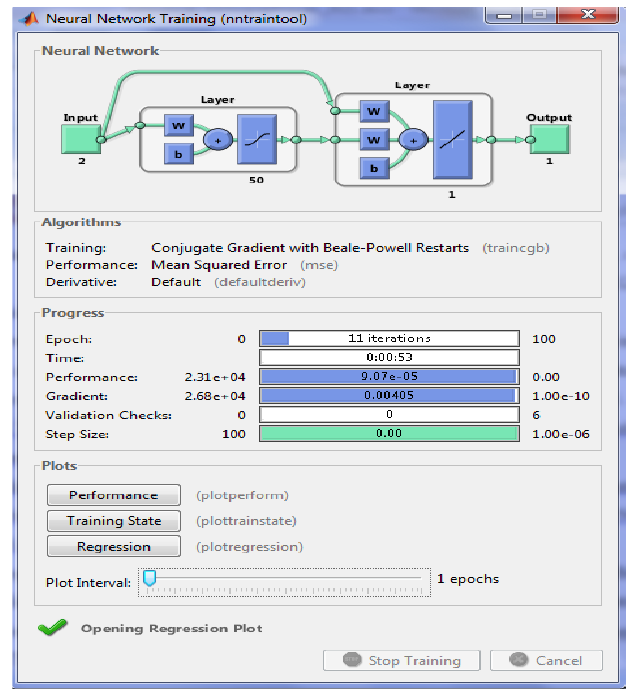
Figure 6. Neural network training.